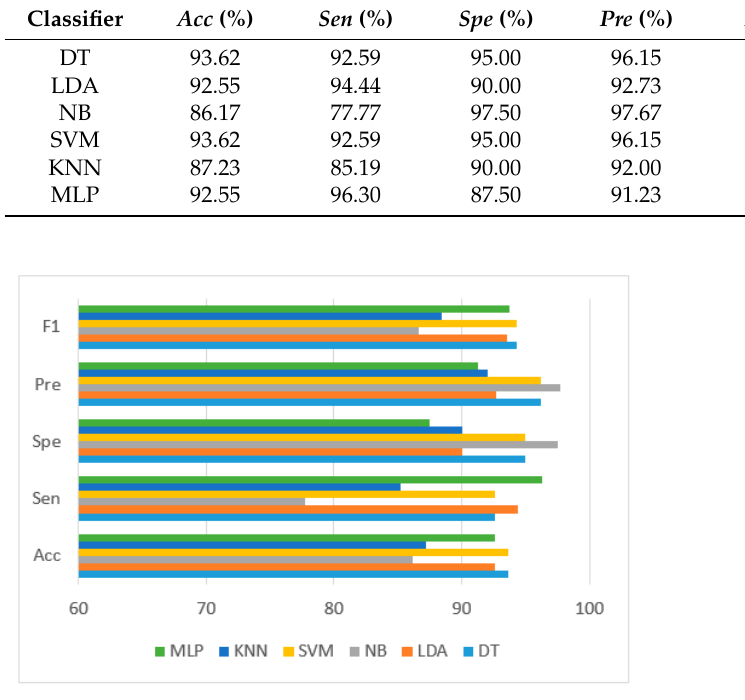
Figure 10. Performance comparison of the classifiers in terms of metrics derived from the confusion matrix.